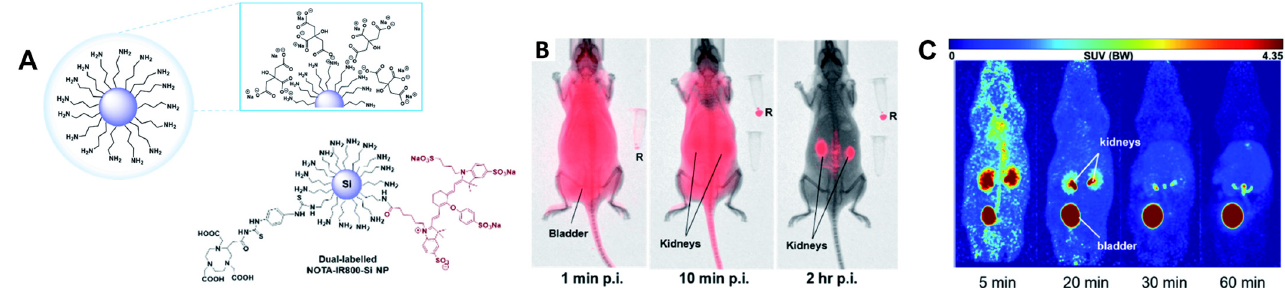
Figure 2. ( A ) The molecular sensitivity and spatial resolution of imaging processes of relevance to this review, * sensitivity not well characterised. Data obtained from [17–19]. ( B ) Schematic of pene- tration depth at varying wavelengths.